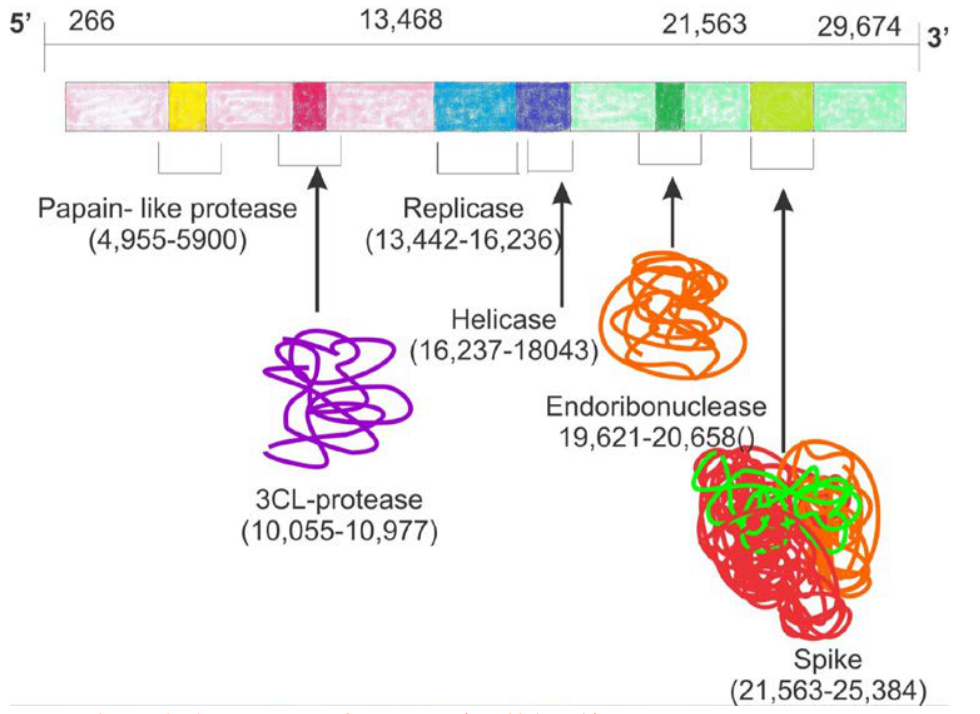
Fig. 3. Single Standard RNA genome of SARS Cov-2 (~30 kb length) The image is modified from source